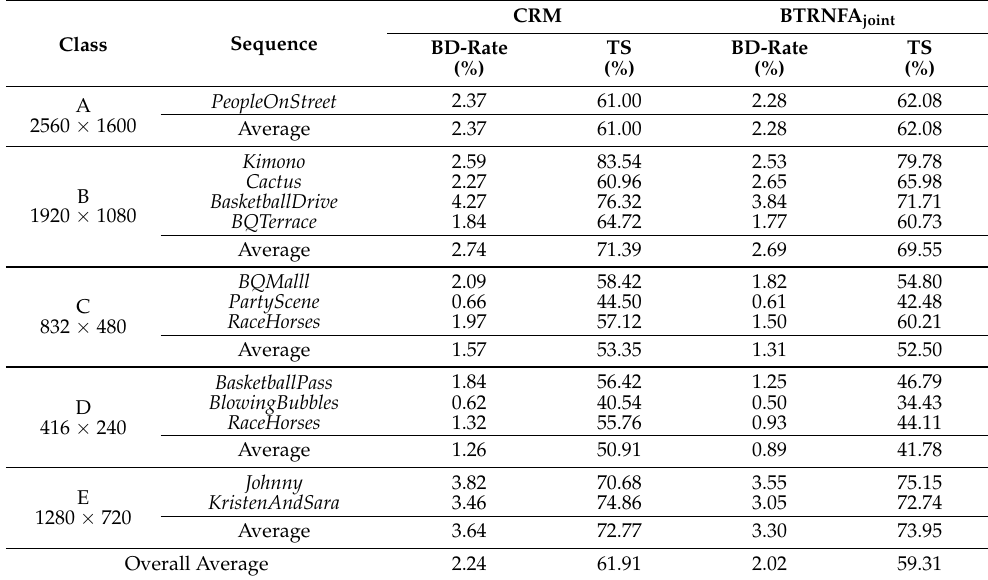
Table 9. Performance comparison between the proposed BTRNFA joint and CRM under HM16.5; all intra coding.